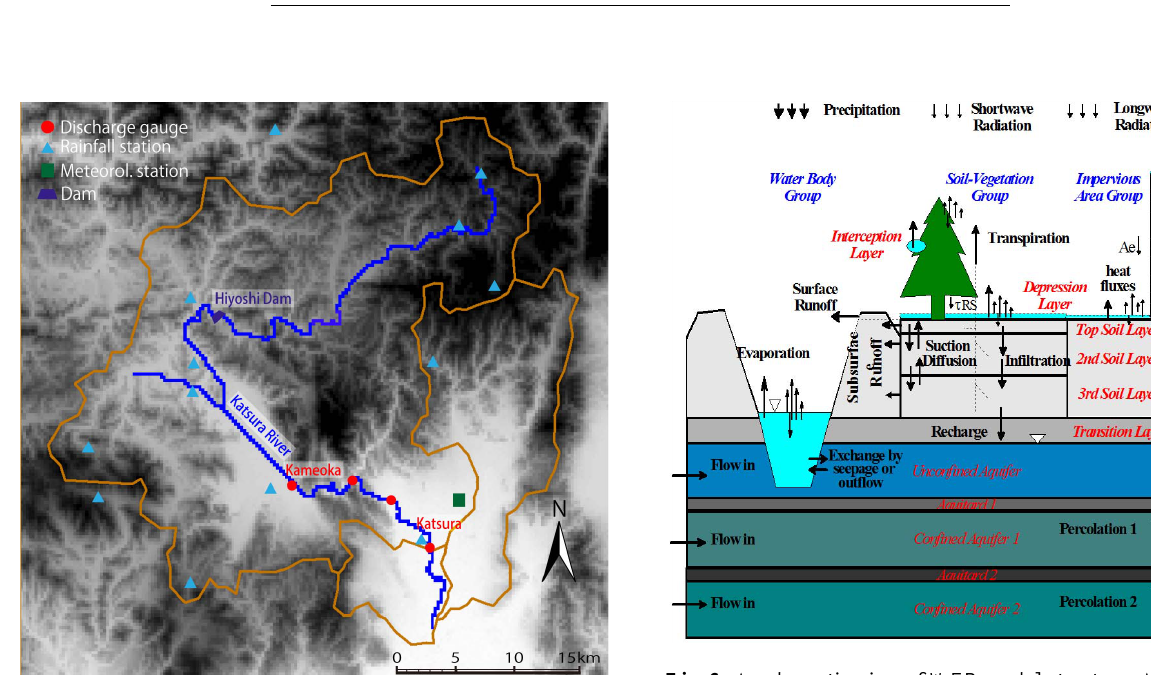
Fig. 5. The Katsura River catchment.